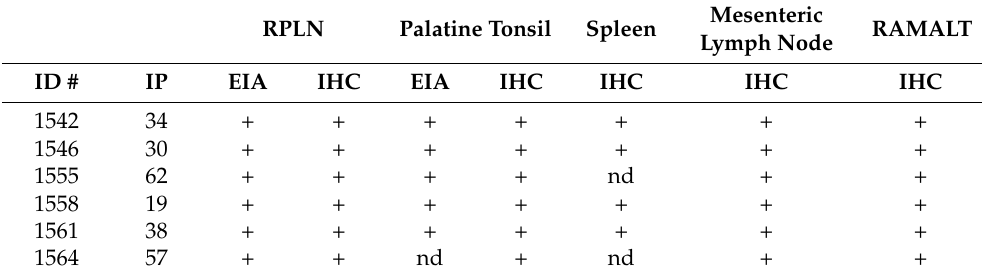
Table 1. Incubation periods and immunodetection of PrP Sc in white-tailed deer oronasally inoculated with raccoon-passaged chronic wasting